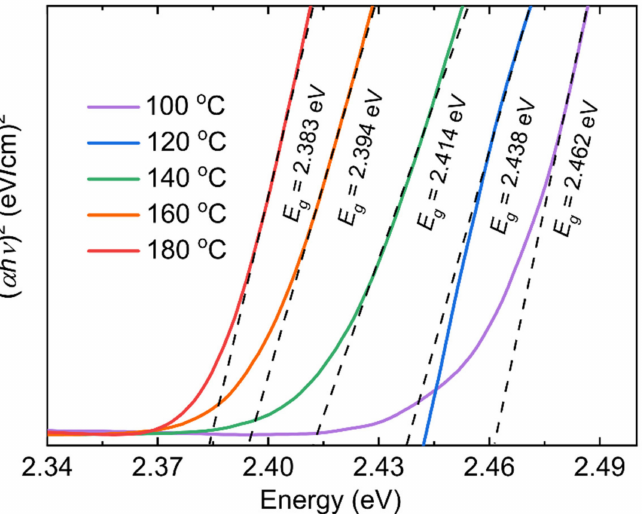
Figure 3. Optical bandgap of CsPbBr 3 perovskite NCs prepared at different reaction temperatures. Dashed lines indicate optical bandgaps determined from Tauc